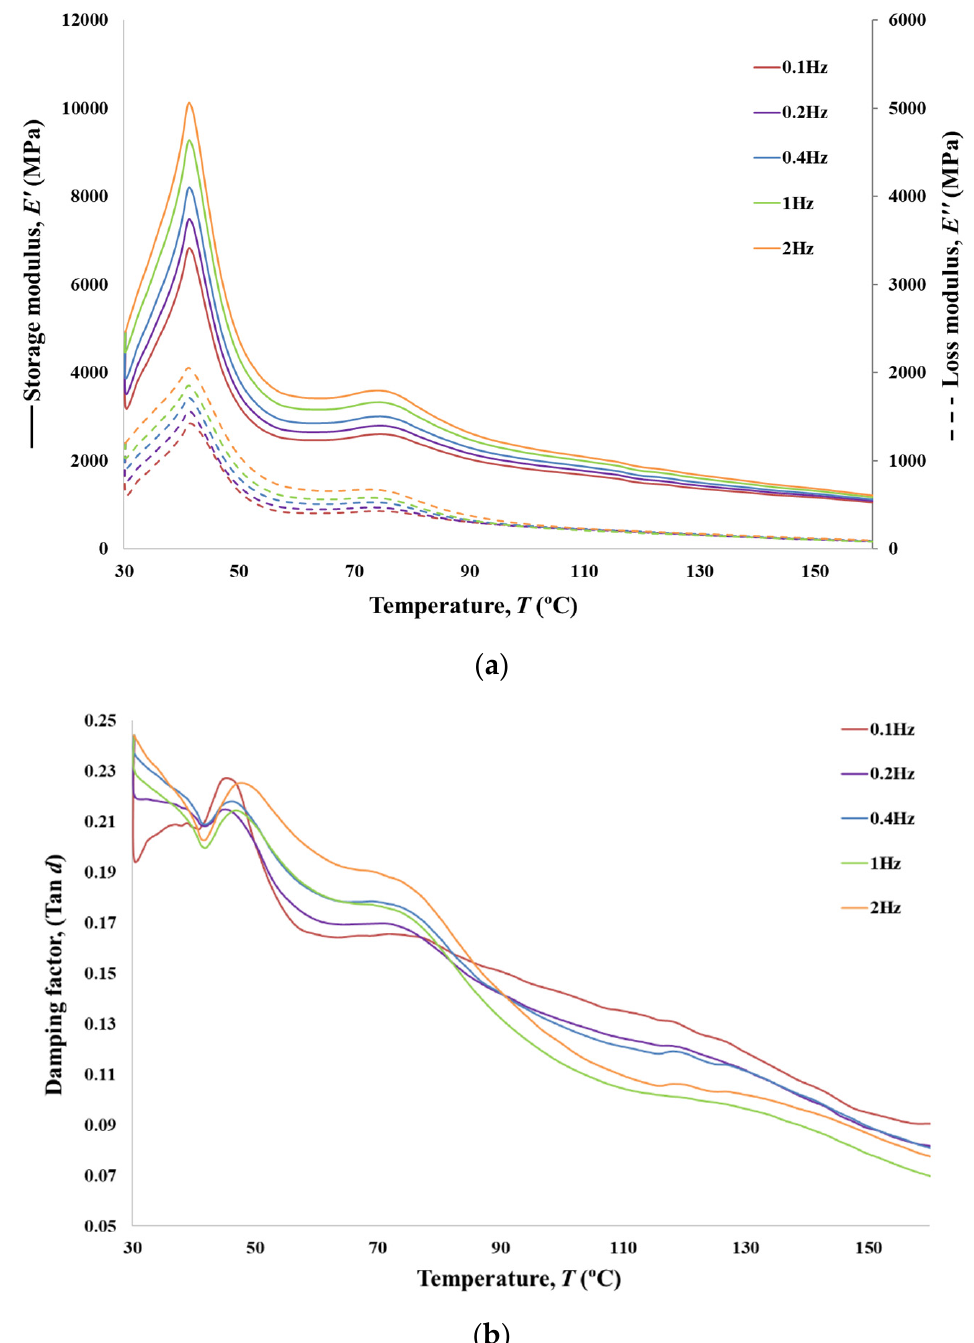
Figure 15. Storage and loss moduli ( a ), and tangent loss ( b ) for PVA 8BY.